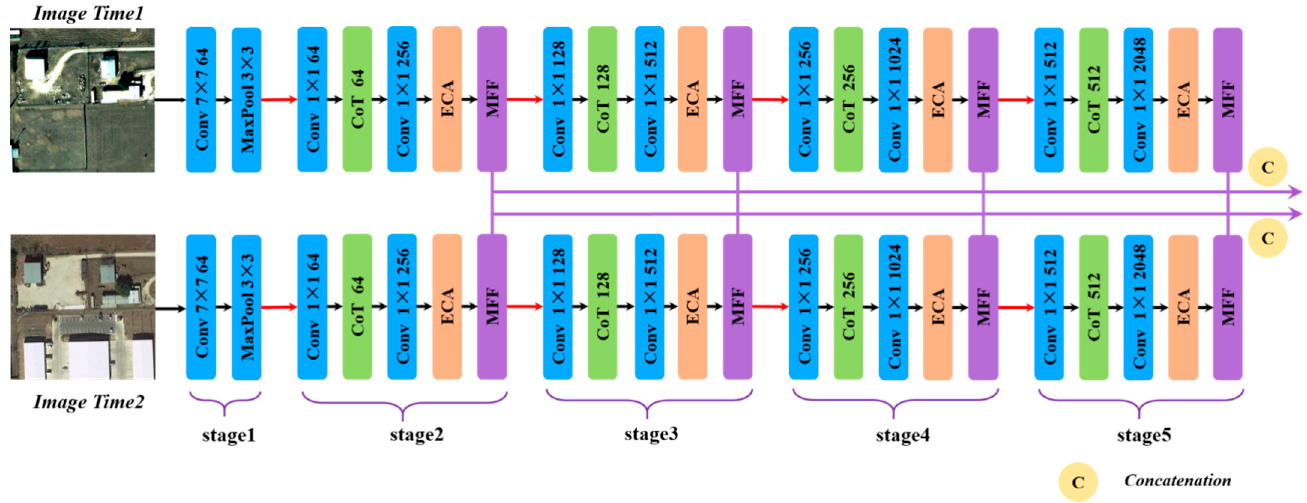
Figure 2. The architecture of the feature extractor.